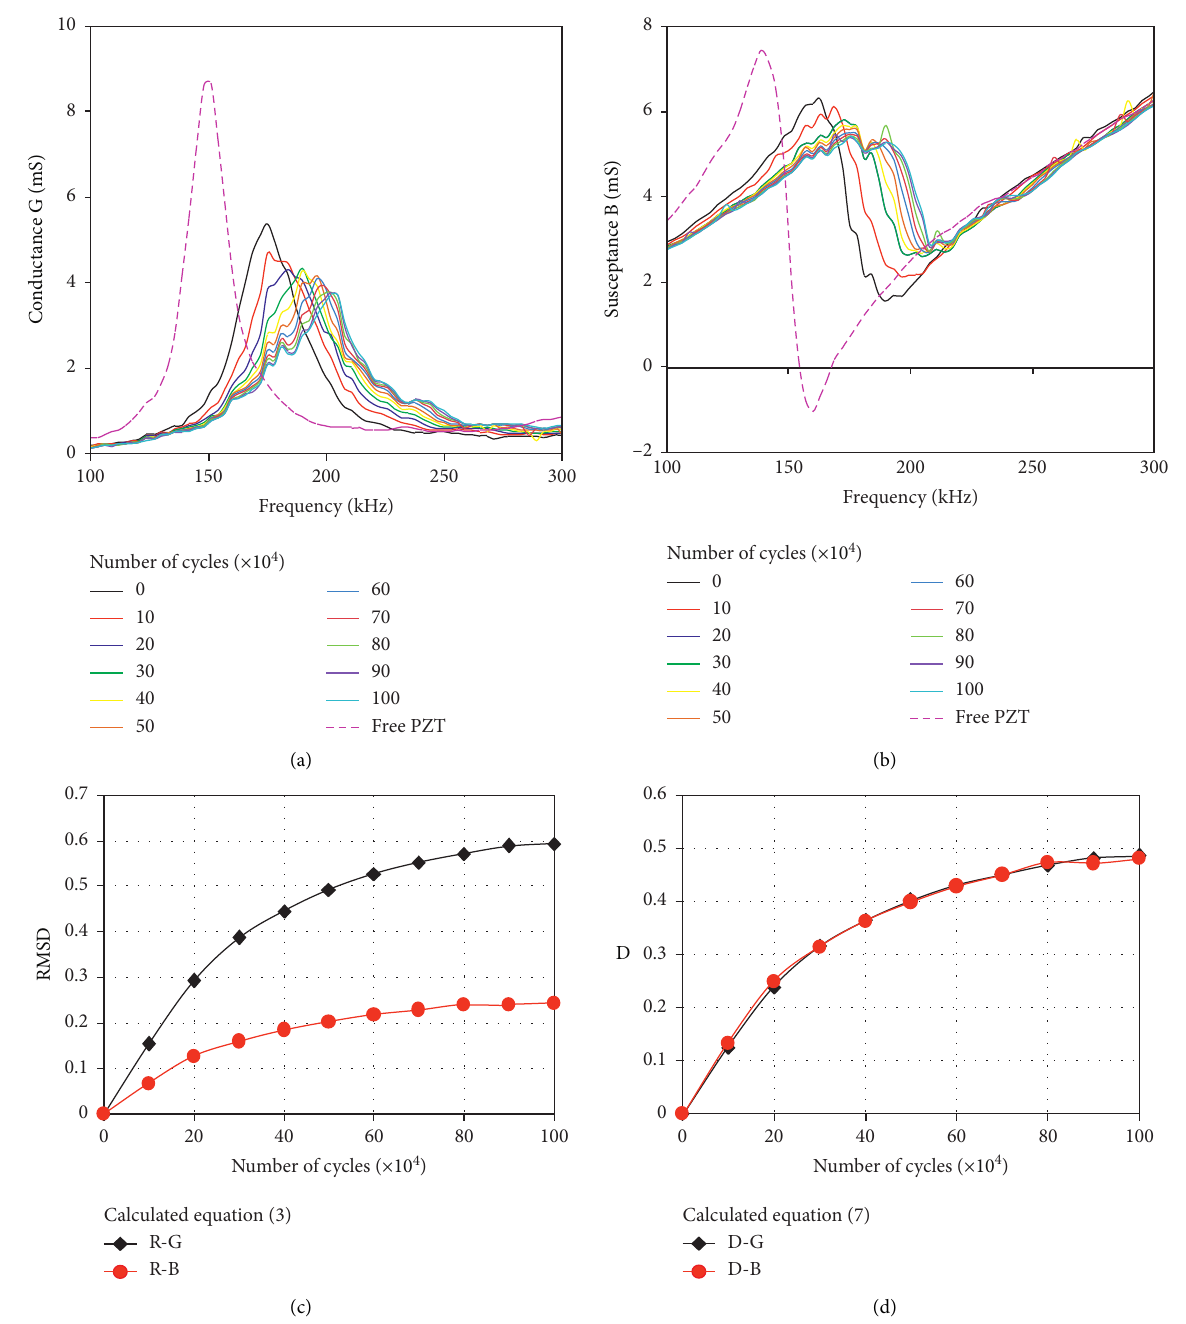
Figure 4: The signatures of specimen I15-1: (a) conductance G; (b) susceptance B; (c) RMSD calculated by equation (3) based on G and B signature (R-G and R-B), respectively; (d) D-G and D-B calculated by equation